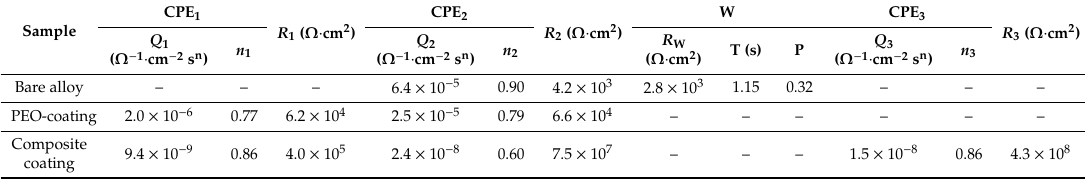
Table 5. Bare alloy, PEO and composite coatings equivalent electrical circuit (EEC) parameters (Figure 8). Sample